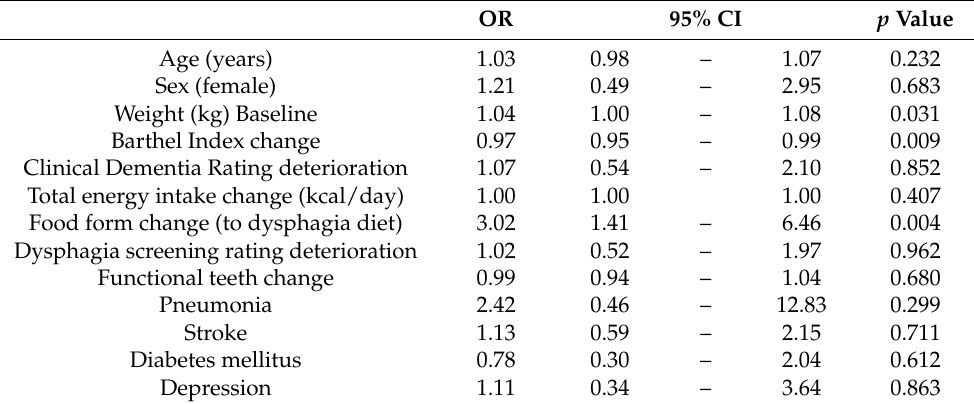
Table 4. Logistic regression analysis of the presence or absence of ≥ 5% weight loss in 1